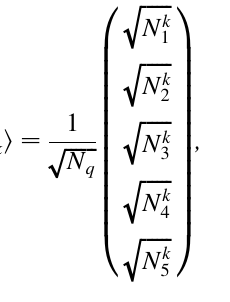
ffiffiffiffiffiffiffiffiffiffiffiffiffiffiffi